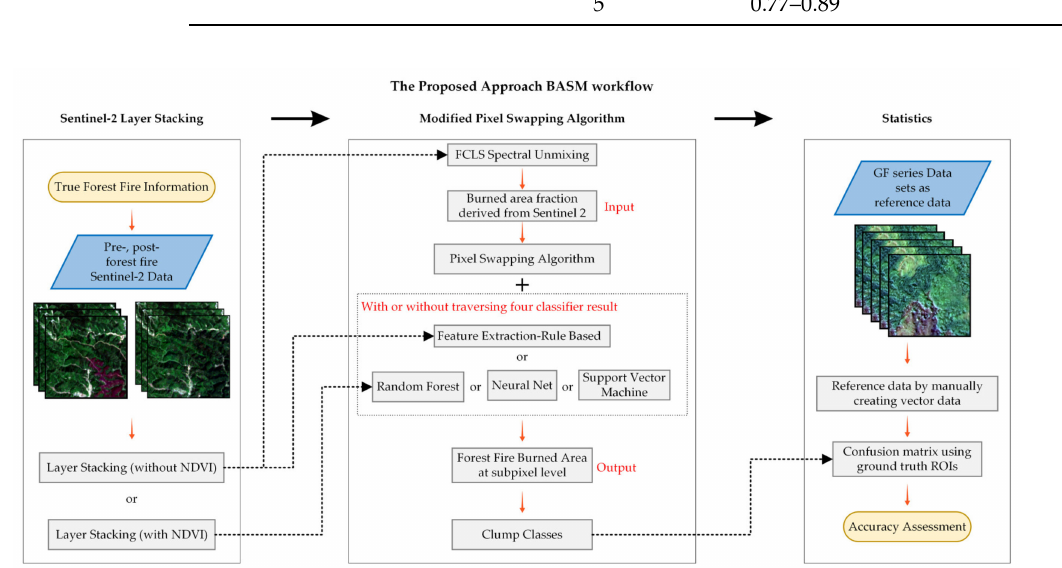
Figure 2. Flowchart for the analysis performed in this